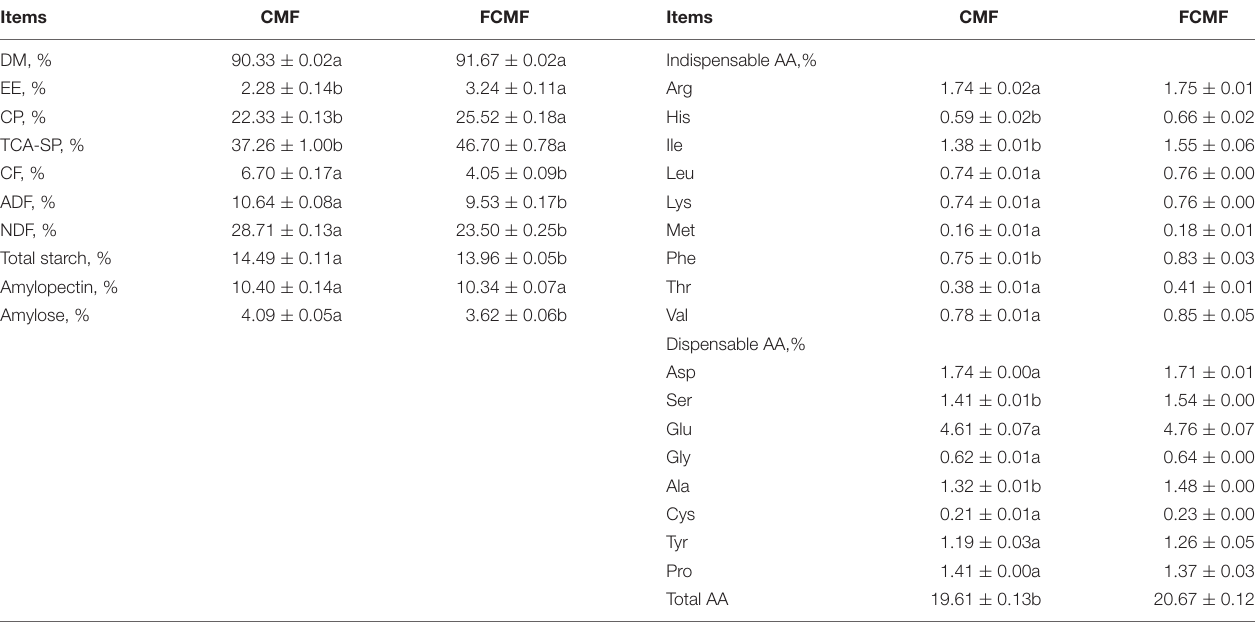
TABLE 2 | Nutrient composition of CMF and fermented CMF (FCMF) (as air-dry basis). Items CMF FCMF Items CMF FCMF